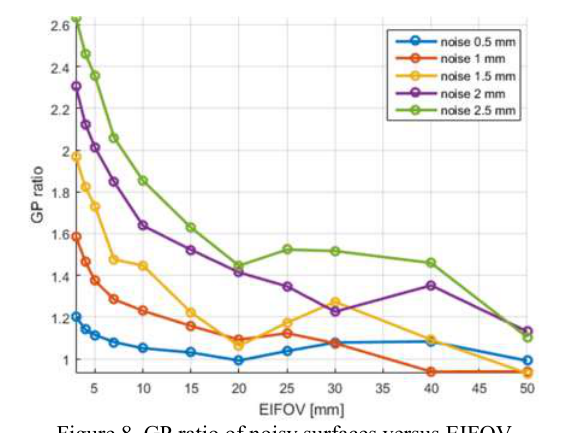
Figure 8. GP ratio of noisy surfaces versus EIFOV.